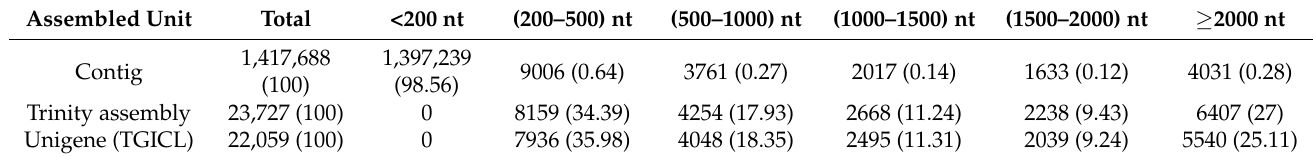
Table 4. Statistics (%) for the de novo assembly of the transcriptome in Mortierella alpina based on Trinity and the TIGR Gene Indices clustering tools (TGICL).